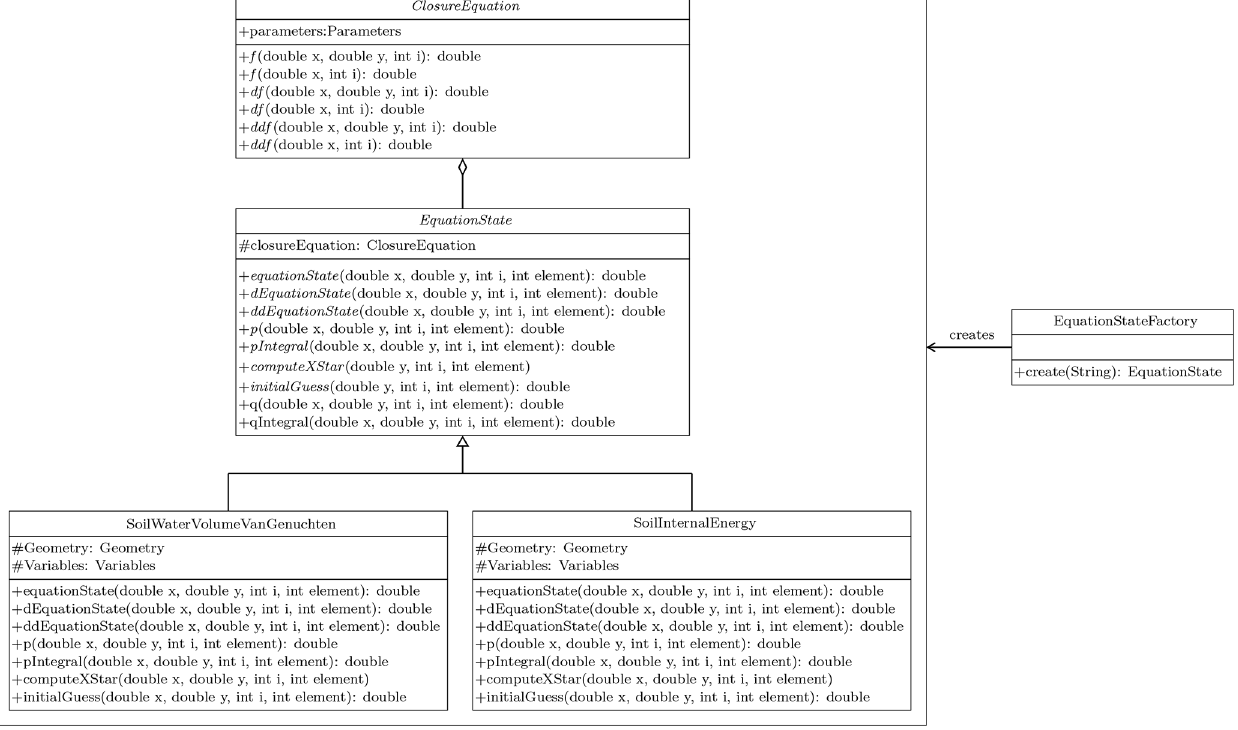
Figure 4. UML class diagram for the Java Simple Factory applied for the choice of the EquationState model. The EquationState defines the interface that is implemented by the concrete classes SoilWaterVolumeVanGenucthen and SoilInternalEnergy . The EquationState contains a reference to a ClosureEquation